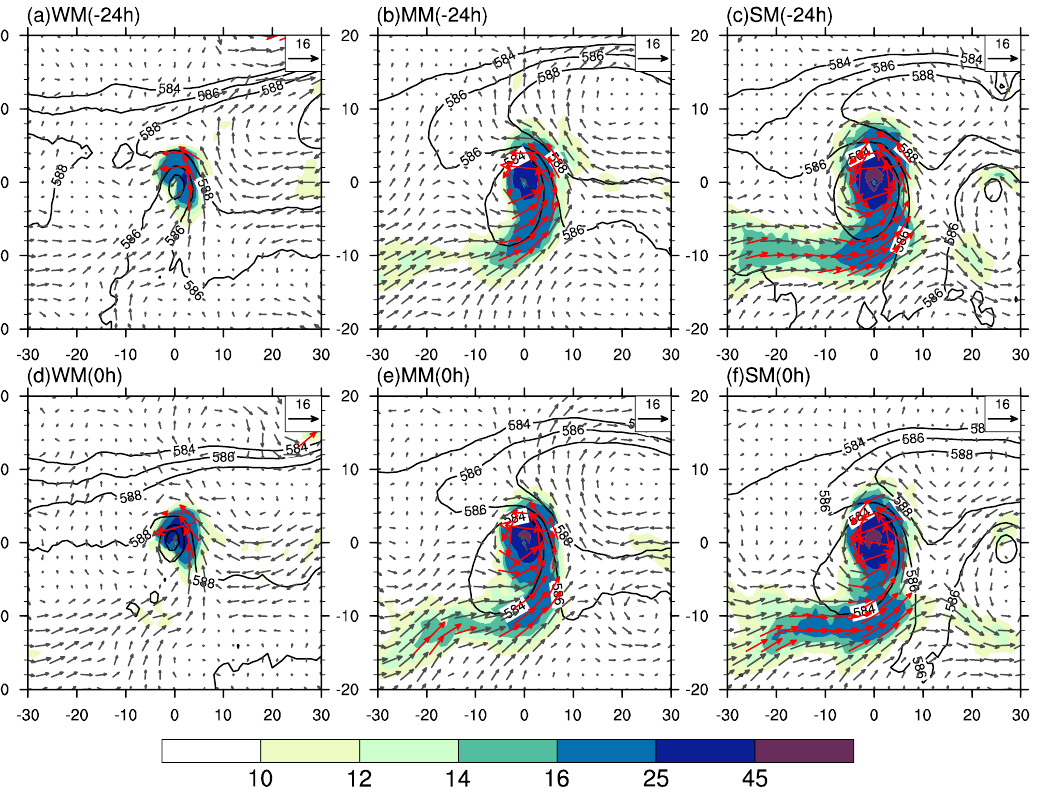
Figure 4. Composite of the 850 hPa wind (vector, m s − 1 ), water vapor flux (shaded, g s − 1 hPa − 1 cm − 1 ), and 500 hPa geopotential height (contour, dam) fields on ( a – c ) 24 h before landfall and landfall time ( d – f ) for cluster WM ( a , d ), MM ( b , e ), and SM ( c , f ), respectively. Red vectors indicate the low-level jet (wind speed ≥ 12 m s −1 ). The origin points (0, 0) are typhoon centers. Positive (negative) coordinates denote the distance from typhoon center by degrees at northward (southward) and eastward (westward) direction.